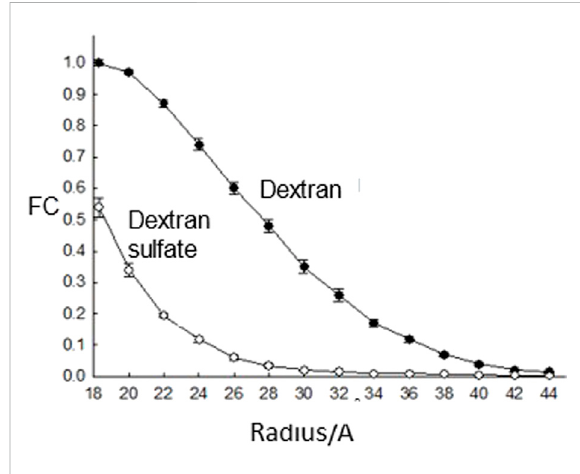
FIGURE 3 The fractional clearance (FC) of dextran sulfate and neutral dextran as a function of molecular radius as studied in rats (Chang et al.,